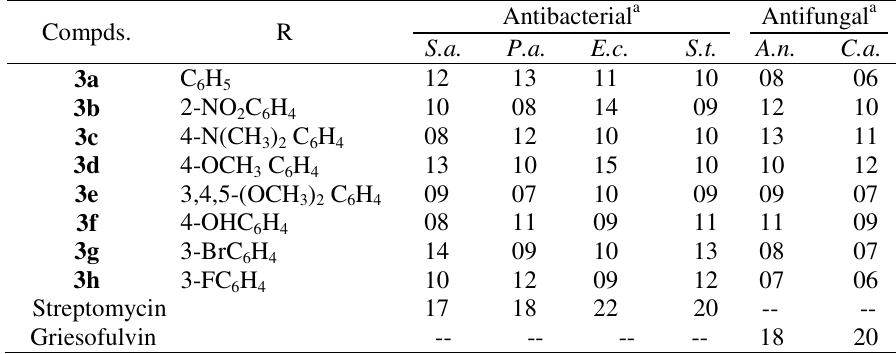
Table 3. Antimicrobial and antifungal data of compounds 3a-h.